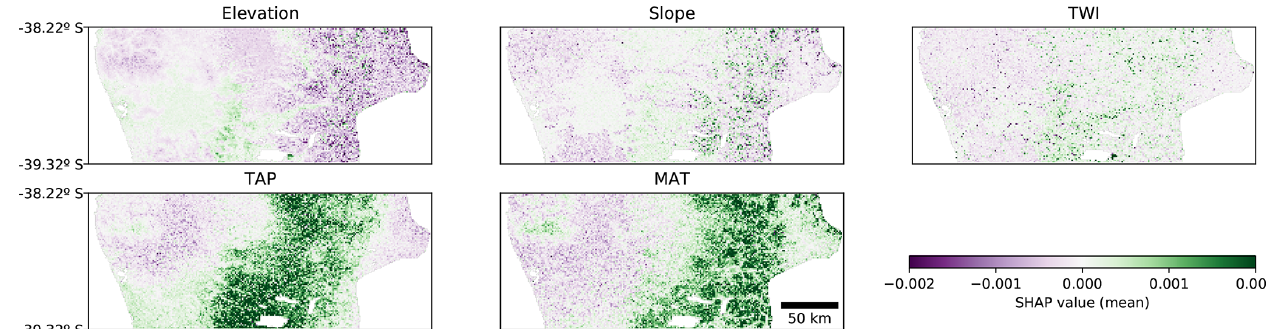
Figure 6. Spatial distribution of SHAP values for each covariate for the CNN model. The value of each pixel is an average of all the instances where that pixel is used as context (up to 841 times for a 29 pixel × 29 pixel context window). TAP: total annual precipitation; MAT: mean annual temperature; TWI: topographic wetness